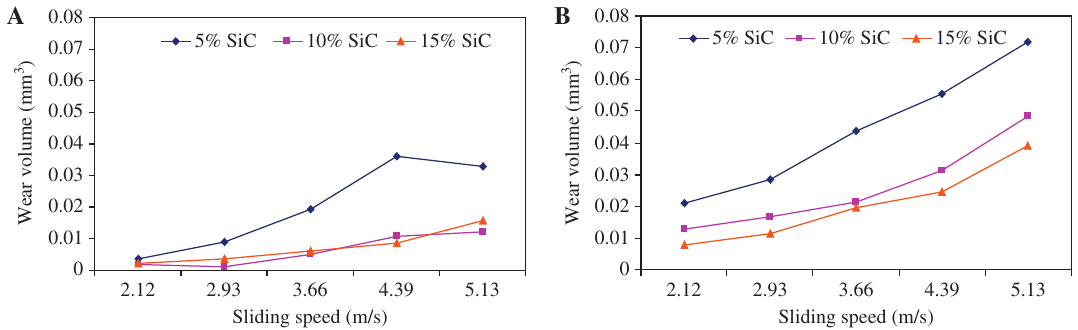
Figure 6 Variation of wear volume with varying sliding speed and